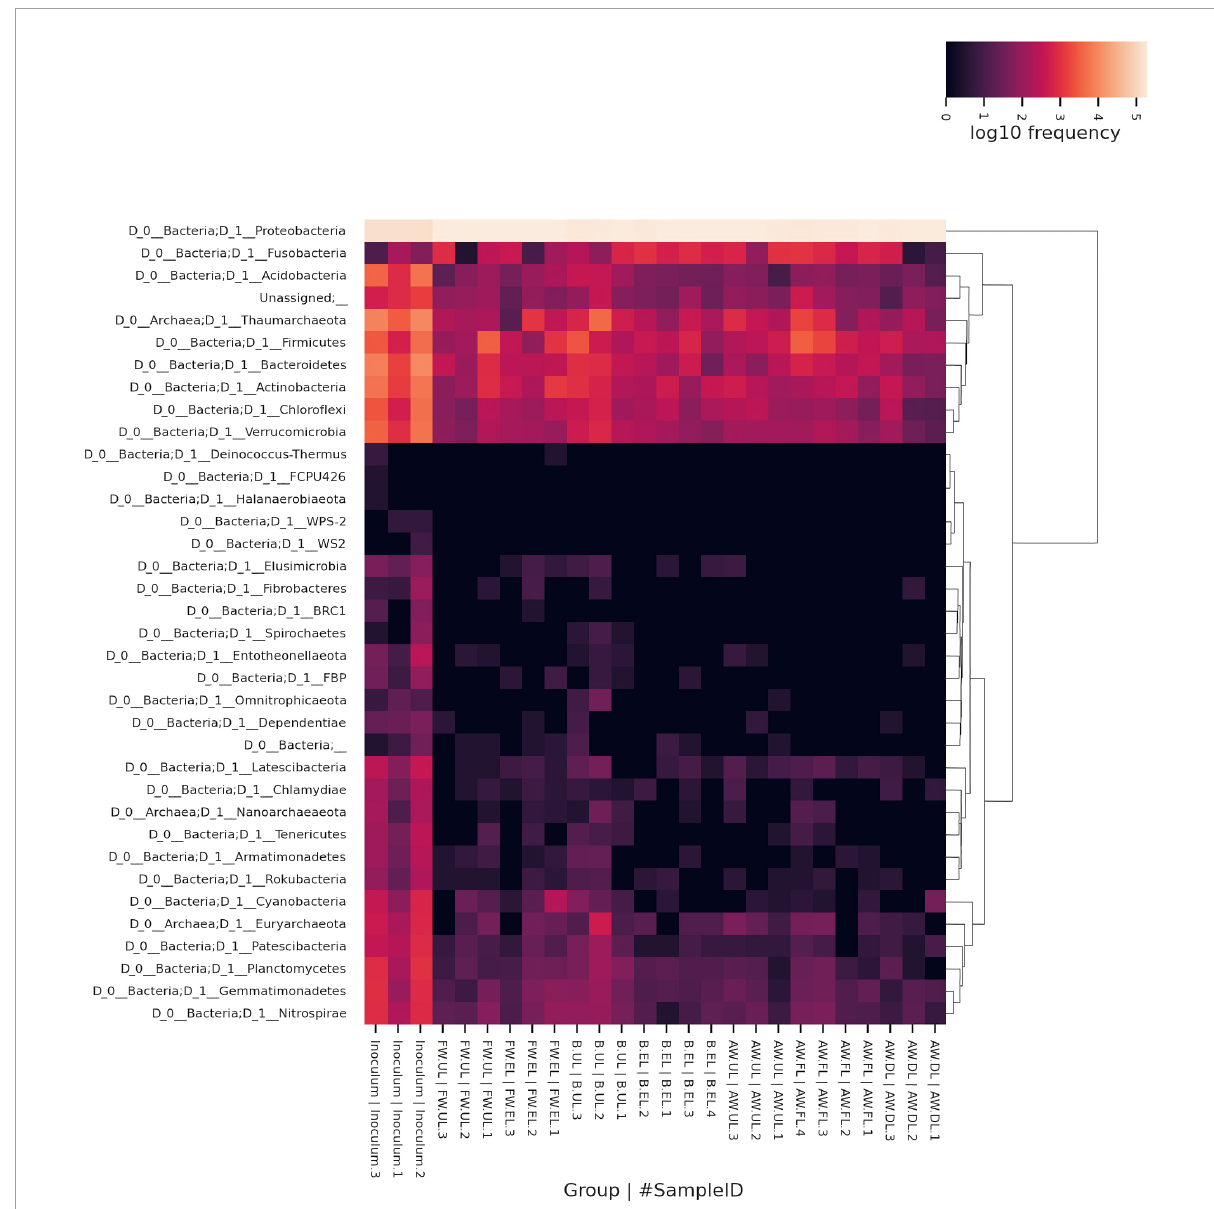
FIGURE6 Heatmap clustering the metagenome taxonomy based on OTUs that comprise each taxon represented up to the phylum level as a maximum specificity. Taxa were grouped by hierarchical clustering for all samples according to their frequency (log10). AW, alcohol wine; B, beer; FW, fine wine; EL, end of loading phase (FL, fast loading; DL, discontinuous loading); UL, just before